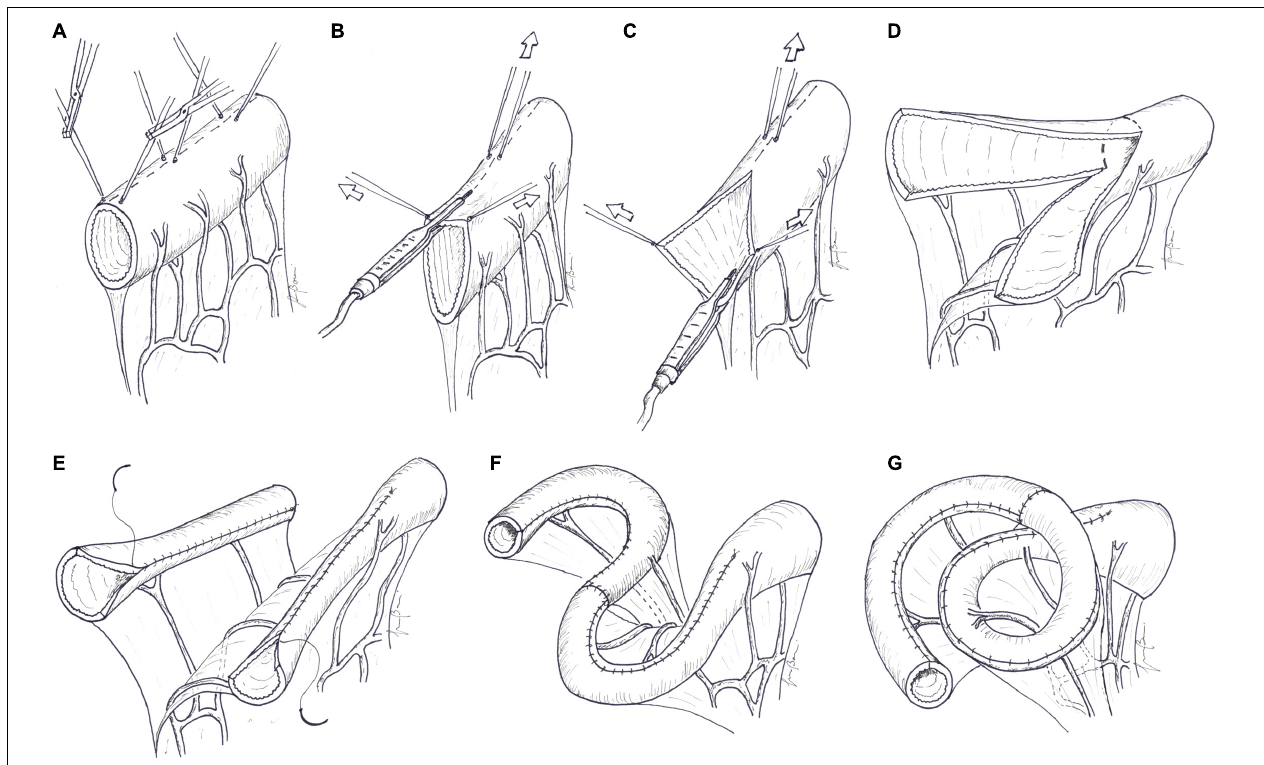
FIGURE 4 | Longitudinal intestinal lengthening and tailoring. (A) A marker line is drawn longitudinally along the midline, in the mesenteric border of the dilated segment of the bowel, as an orientation guide. Traction sutures are placed along the antimesenteric border to the right and left of the midline, at about 5–10 cm intervals. (B) The antimesenteric border is divided longitudinally, passing between the traction sutures, by bipolar diathermy. (C) Outward and upward tractions of the opened bowel loop against the base of the mesentery gives access to the blood vessels between the two layers of the mesentery. The avascular space between the mesenteric vessel and the bowel wall is developed by blunt dissection. The mesenteric border is then divided longitudinally in the midline by cutting bipolar diathermy. (D) Longitudinal bowel division along the mesenteric border develops two vascularized hemi-segments. (E) One of hemi-segments is completely detached by division along the lateral wall and tubularized with a continuous suture. The other hemi-segment, in continuity with the proximal bowel, is tubularized in the same manner. (F) The two new hemi-loops are then anastomosed to each other in an isoperistaltic fashion. This can be accomplished in a “lazy S” shape or in a “spiral” shape (G) , as described by